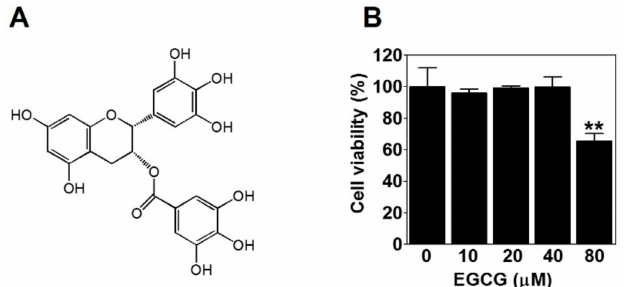
Figure 1. The e ff ect of epigallocatechin-3-gallate (EGCG) on the viability of PC-3 cells. ( A ) Chemical structure of EGCG. ( B ) Cells were treated with various concentrations of EGCG (10, 20, 40, and 80 µ M) for 24 h, and cell viability was determined by MTT assay. Data are expressed as means ± SD. Results were statistically calculated by Student’s t -test. ** p < 0.01 vs. untreated control.